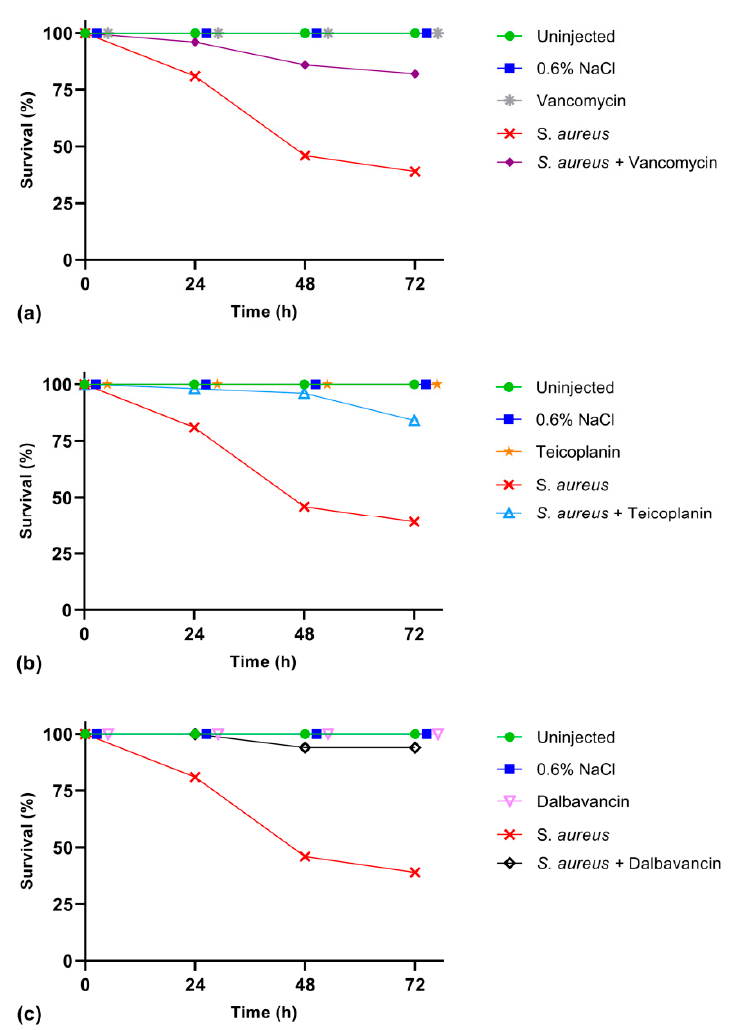
Figure 3. Survival rate of healthy larvae and larvae infected with S. aureus (3 × 10 2 colony forming units) when treated with vancomycin ( a ), or teicoplanin ( b ), or dalbavancin ( c ). The antibiotic dose was 8.75 µ g / g body weight. Results reported in ( a – c ) are from the same experiment run in parallel, using the same control groups (healthy larvae uninjected and injected only with saline solution) and infected larvae.